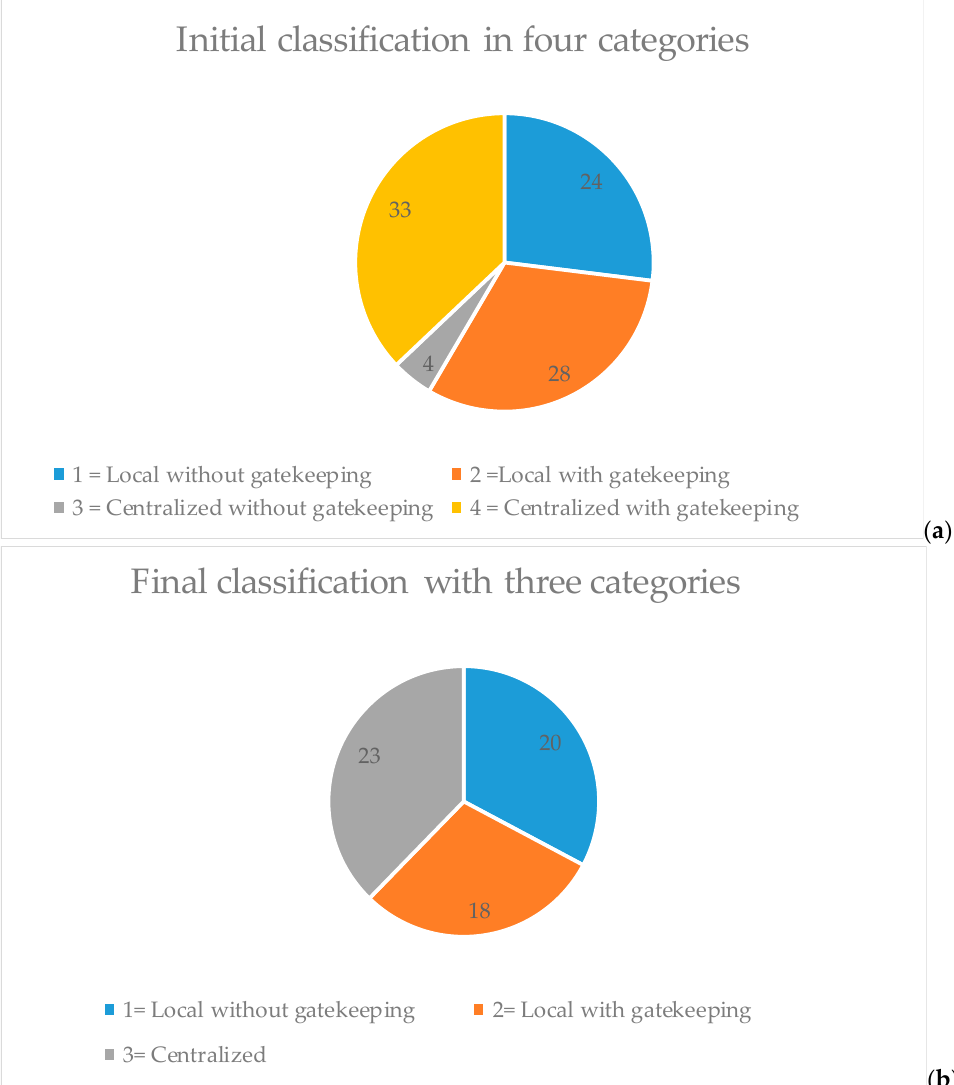
Figure 2. Proportions of different main types of care (MTCs) classified as local or centralized; initial and final classifications. Initial classifications ( a ) and final classifications ( b ) represented